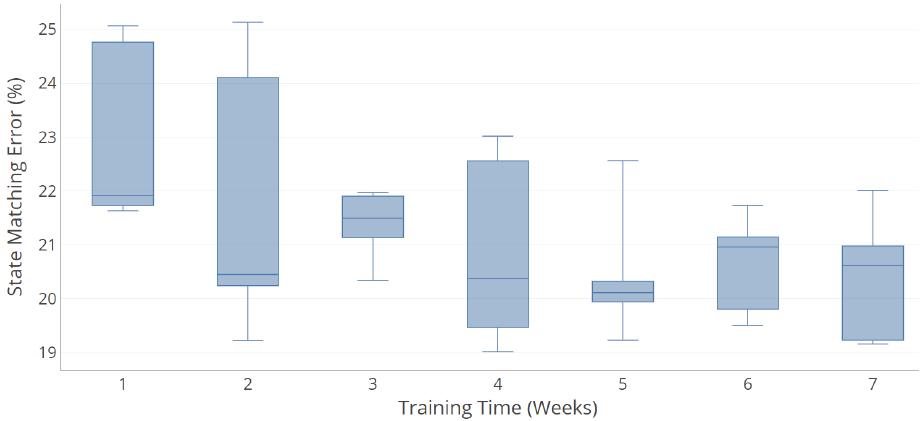
Figure 7. State matching error for House 1, by number of training